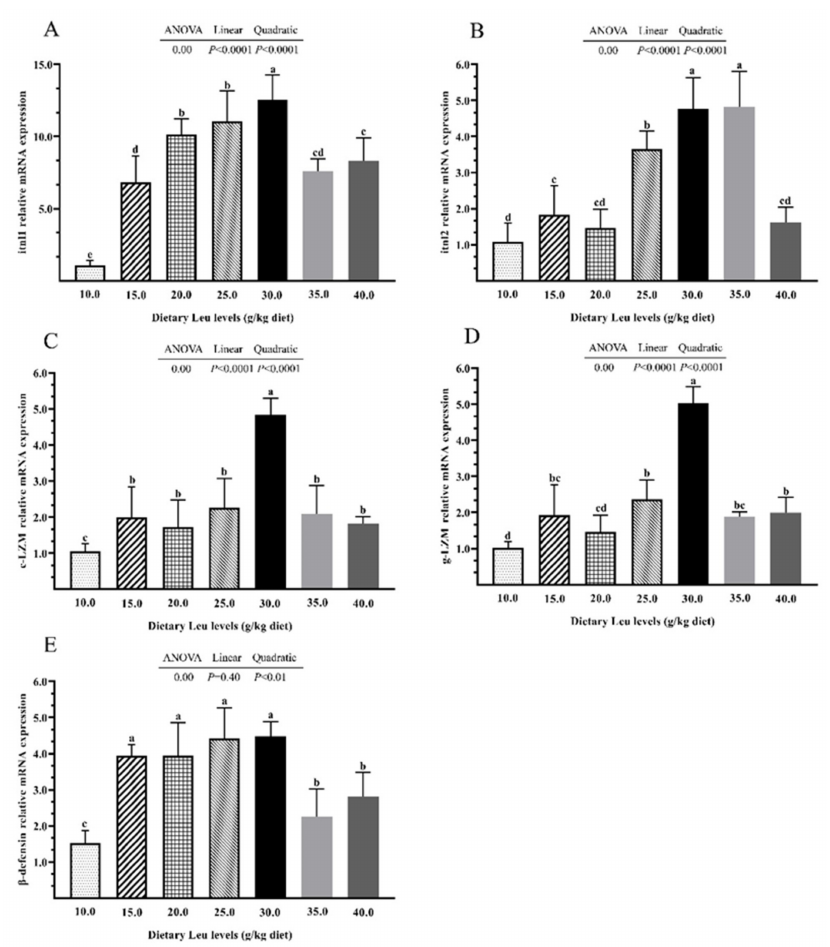
Figure 1. Effects of dietary Leu on itnl1, itnl2, c-LZM, g-LZM, and β -defensin mRNA expressions in intestine of hybrid catfish fed diets with graded levels of Leu (g/kg) for 56 days. ( A – E ) The mRNA expressions of itnl1, itnl2, c-LZM, g-LZM, and β -defensin. Results are represented as means ± SEM (n = 3 × 6), with six fish in each replicate. Duncan’s multiple range test was used to detect significance. Different superscripts above the bars indicate significant differences ( p <